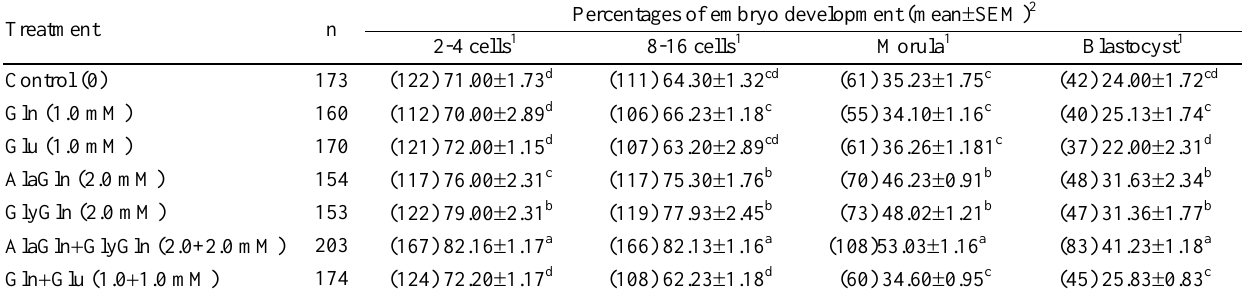
Table 3. Effects of glutamine (Gln), glutamic acid (Glu), L-alayl-L-glutamine (AlaGln), L-glycyl-L-glutamine (GlyGln) and their combinations on the development of porcine embryos